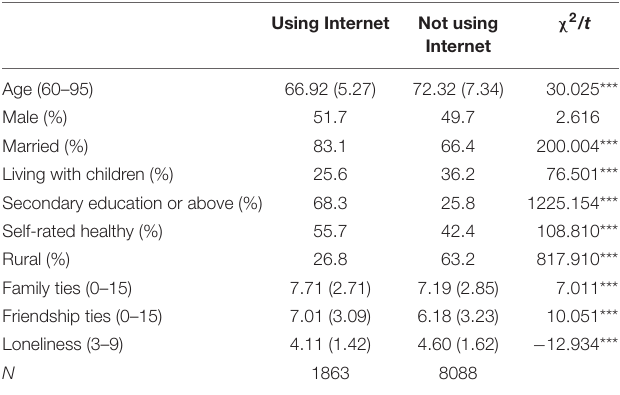
TABLE 1 | Descriptive statistics of the sample.